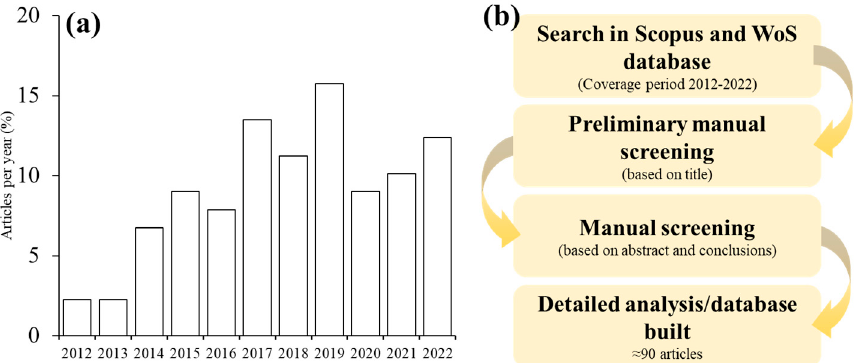
Figure 1. Evolution of the peer-reviewed articles published during 2012–2022 describing results of stone consolidation (only articles reporting strengthening effects) ( a ) and the methodology for building the database in this document ( b ).